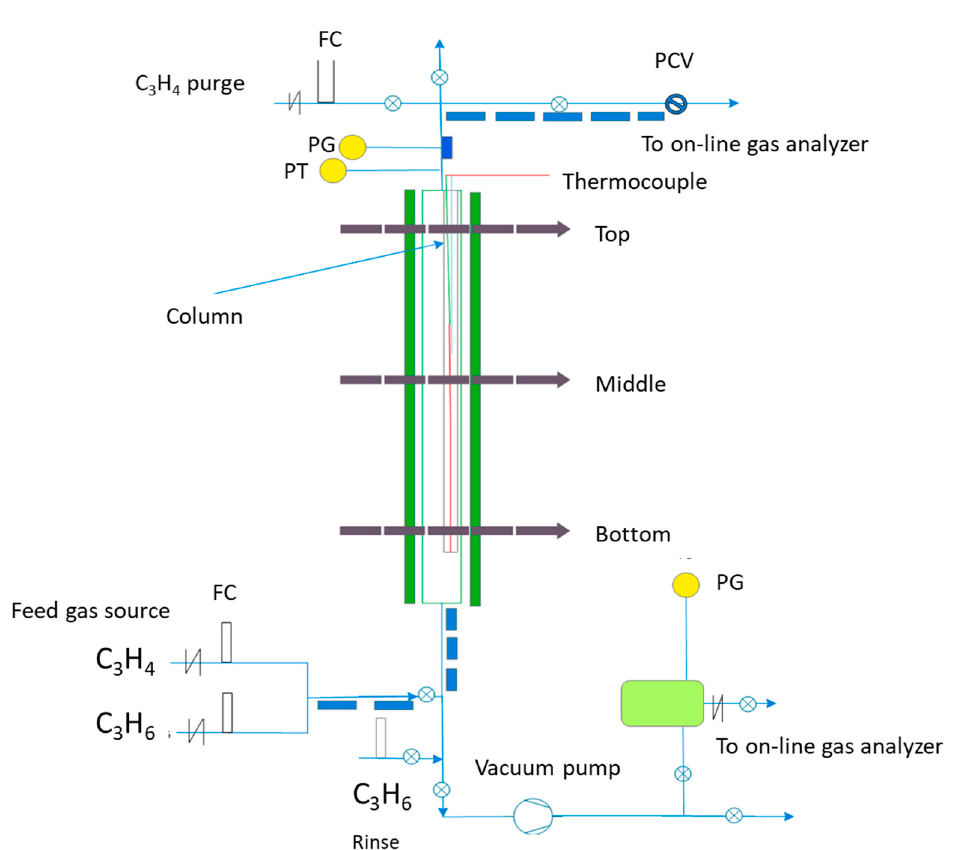
Figure 2. Schematic showing the fixed bed column (Vacuum Pump—Rocker Scientific, New Taipei City, Taiwan, China; Pressure control valve—SS-43GXS4 Swagelok, Solon, Ohio, USA; Mass Flow Controllers Bronkhorst High-Tech B.V, Nijverheidsstraat, The Netherlands).